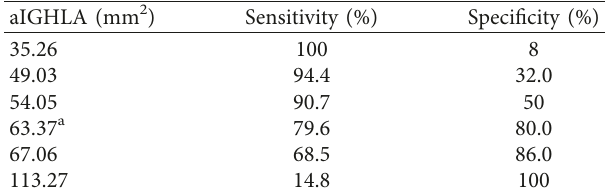
Table 3: Sensitivity and specificity of each cut-off point of the aIGHLA. aIGHLA (mm 2